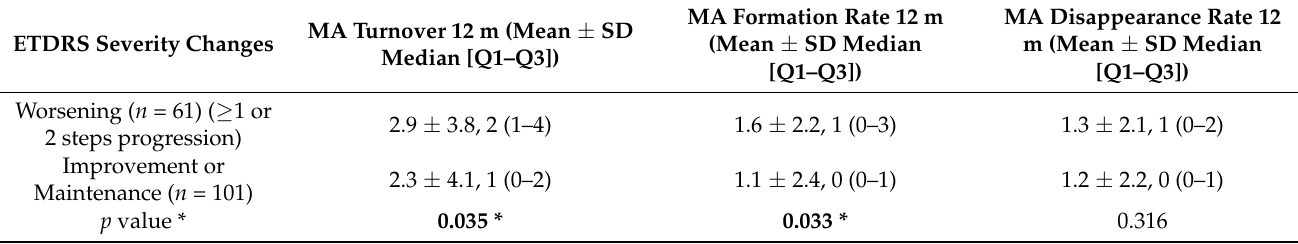
Table 3. Association of MA changes with DR severity progression over 5-years of follow-up.